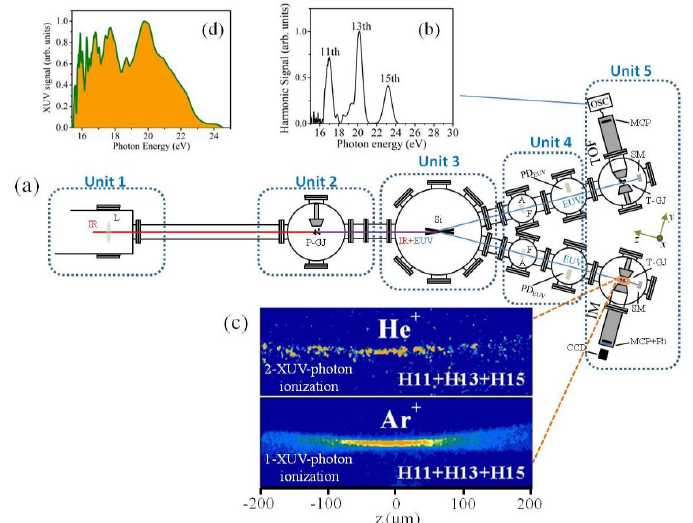
Figure 8. ( a ) Beam line for the generation of intense asec pulses in gas phase media. L: Lens; P-GJ: